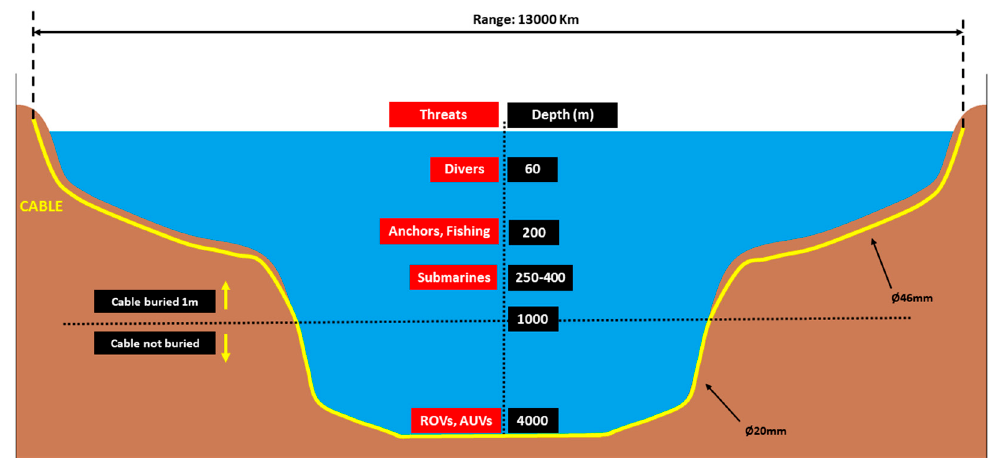
Figure 6. Schematic synthesis of the underwater environment of the multi-threat sabotage scenario. Ø = cable diameter.